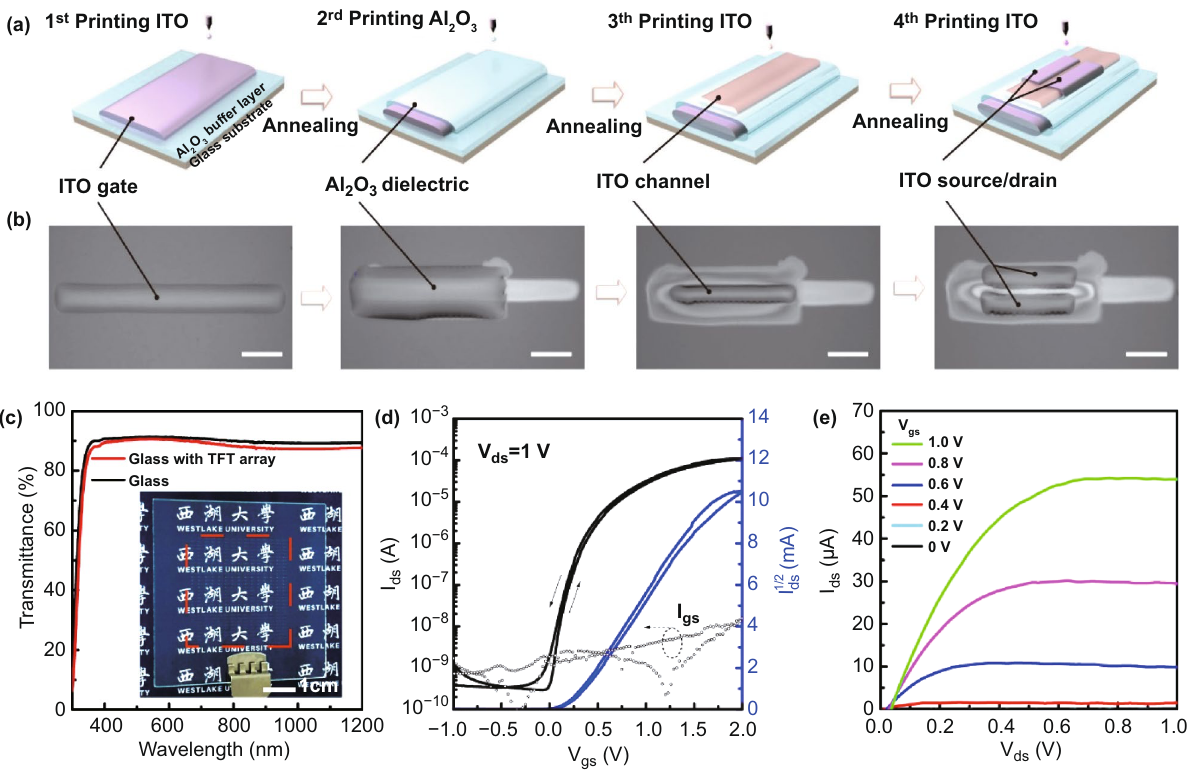
Fig. 2 Process flow of fully inkjet-printed ITO TFTs and electrical characteristics. a Schematic illustration of the printing processes. Each film was annealed at 350 °C for 1 h after printing. b Corresponding optical images of each film right after printing and before annealing. Scale bars: 200 µm. c Optical transmission spectrum of fully printed TFT array on glass. Inset shows a digital photo of a glass with ITO TFT arrays. The red dashes indicate the distribution area of the printed TFT devices. d Transfer curves of the fully-printed TFT with ITO channel thickness of ~ 10 nm, and channel length/width = 40/600 µm. e Output characteristics of the ITO TFT with V gs changed from 0 to 2 V in steps of 0.5 V, showing clear pinch-off